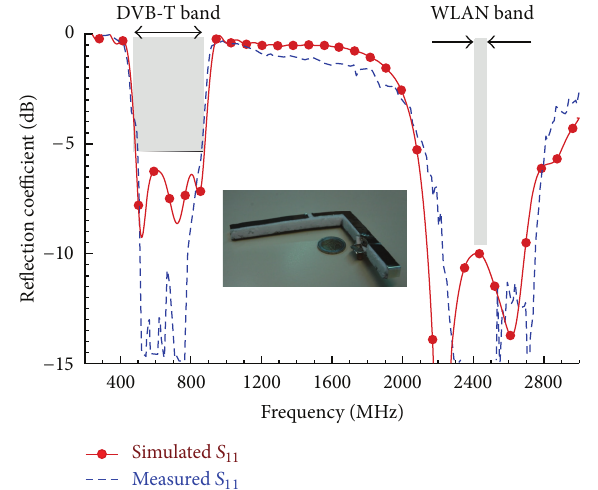
Figure 18: Simulated and measured reflection coefficient for the proposed dual-band L-shape PIFA.